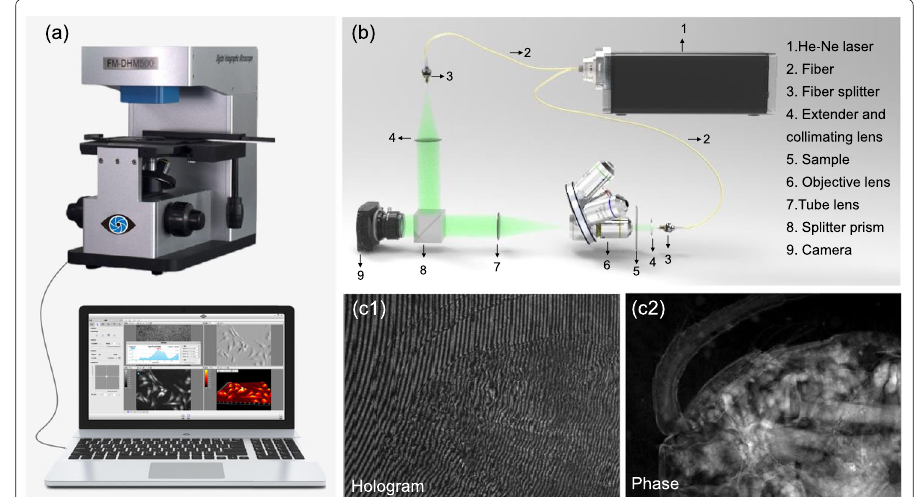
Fig. 5 Schematic diagram of our DH-SCLM. (a) The hardware configuration of DH-SCLM. (b) Interference optical path. (c1) Recorded interference hologram. (c2) Recovered quantitative phase